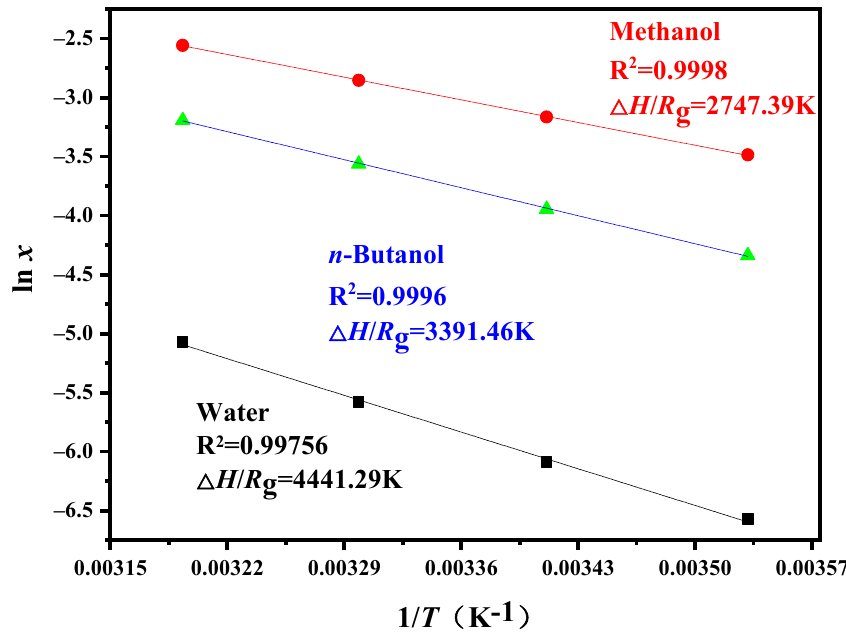
Figure 2. The experimental solubility of AA in water, methanol and n -butanol.